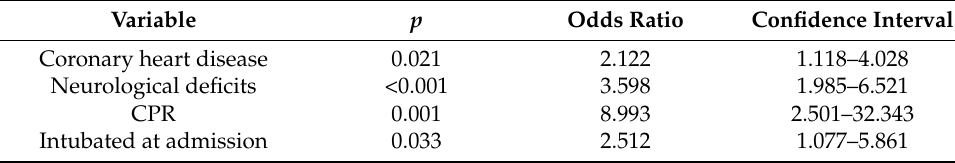
Table 4. Multivariable analysis of risk factors for the combined endpoint.